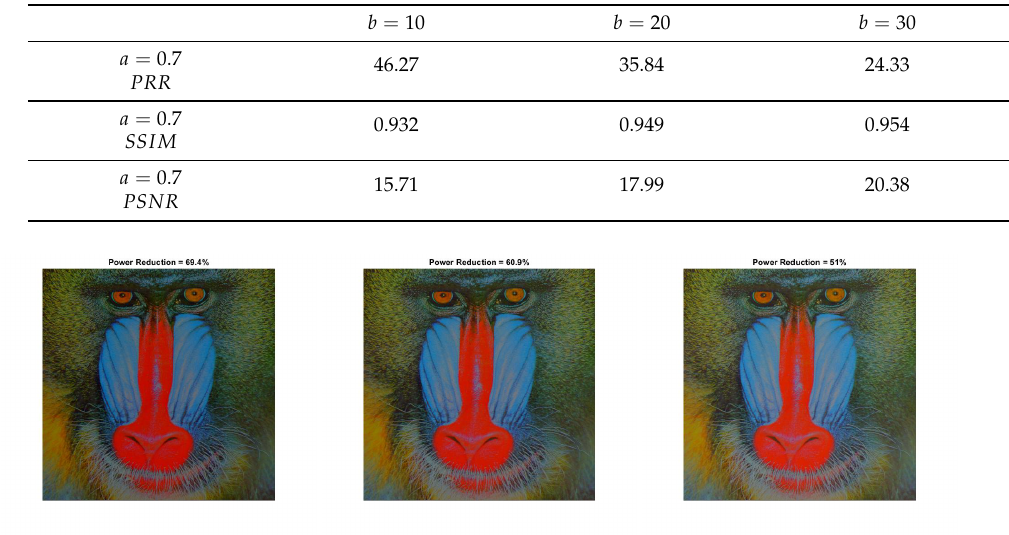
Figure 9. Baboon resulted image I new using Y CBCS (without HE) for a = 0.5 and b =